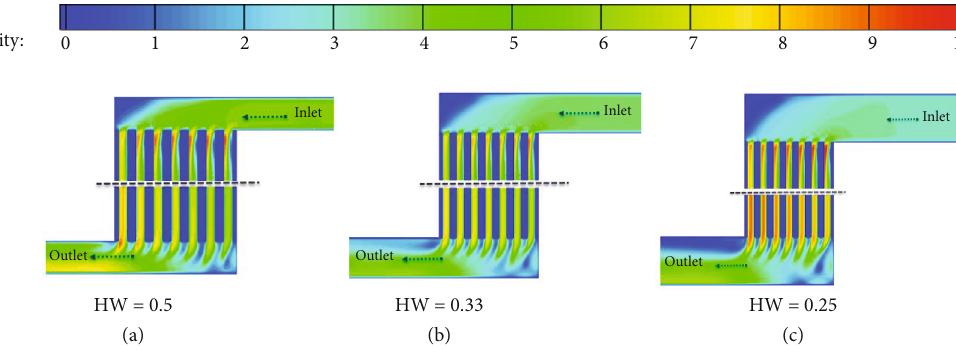
Figure 13: The velocity fi elds in the center planes with di ff erent HW values: (a) HW = 0 : 5, (b) H W = 0 : 33 , and (c) HW = 0 : 25